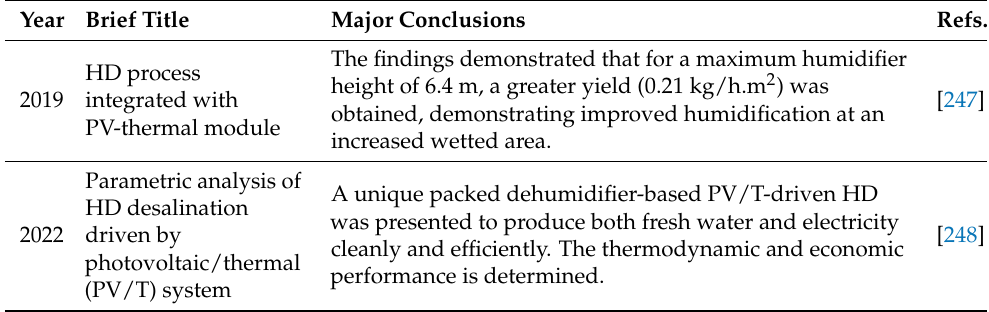
Table 8. A brief survey of the experimental literature on the photovoltaic-based HD